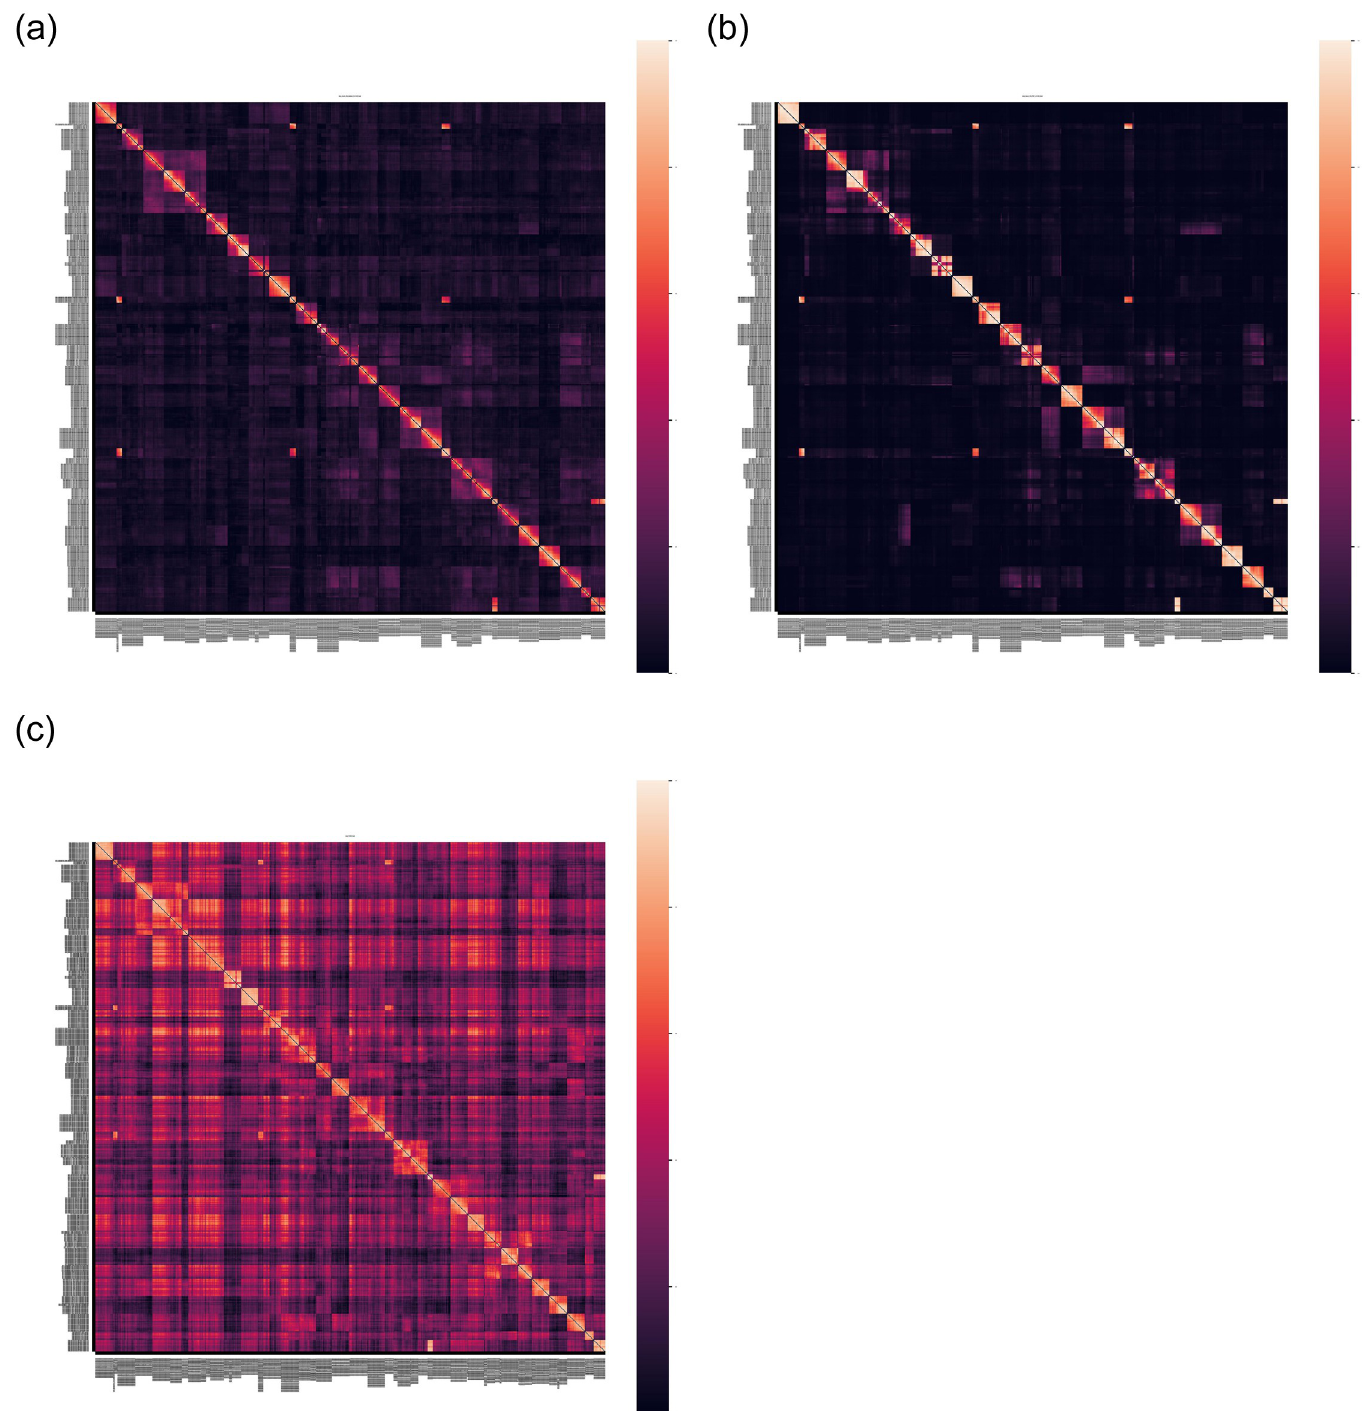
Fig 8. Heatmaps of firm similarity matrices of the products of the firms in the 2018 DJIA, according to the BOOLEAN (top left), TF-IDF (top right), and PVDM (bottom left) models. Compare with the SIC model similarity matrix shown in Fig 4.